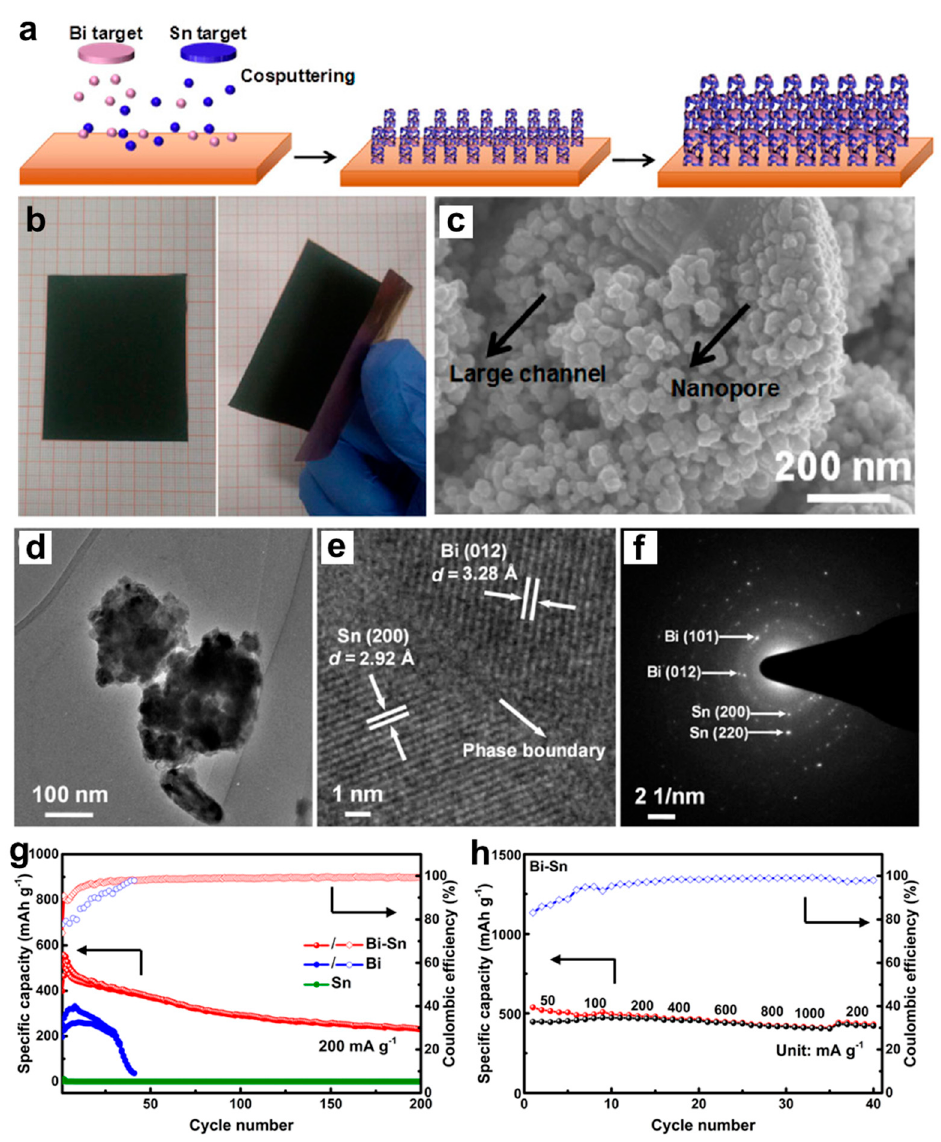
Figure 12. ( a ) Schematic illustrations showing the preparation procedure of the biphase eutectic-like Bi-Sn film. ( b ) Photographs of the sputtered Bi-Sn film showing its flexible, self-supporting, robust feature. ( c ) SEM, ( d ) TEM, ( e ) HRTEM and ( f ) corresponding SAED images of the biphase Bi-Sn film. ( g ) The cycling stability of the sputtered Bi, Bi-Sn electrodes at 200 mA g − 1 and Sn electrode at 10 mA g − 1 . ( h ) Rate performance of the biphase Bi-Sn electrode at different current densities. Reproduced with permission [49]. Copyright 2019, Springer Nature.